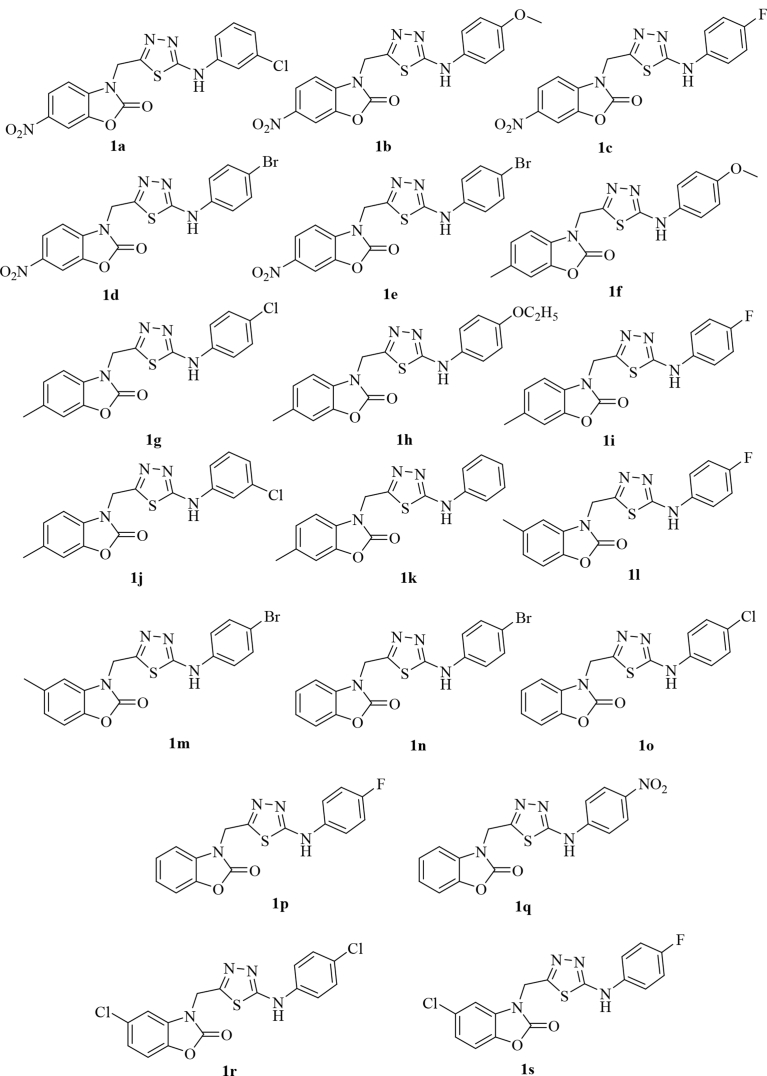
Structures of the synthesized compounds.